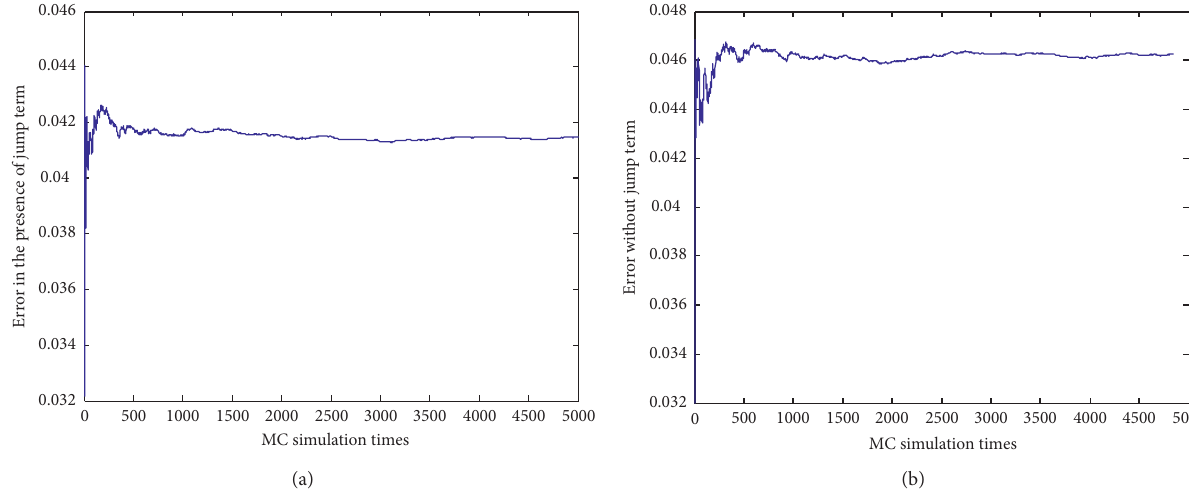
Figure 8: Comparison of simulated value error under two interest rate models: (a) in presence of jump term; (b) without jump